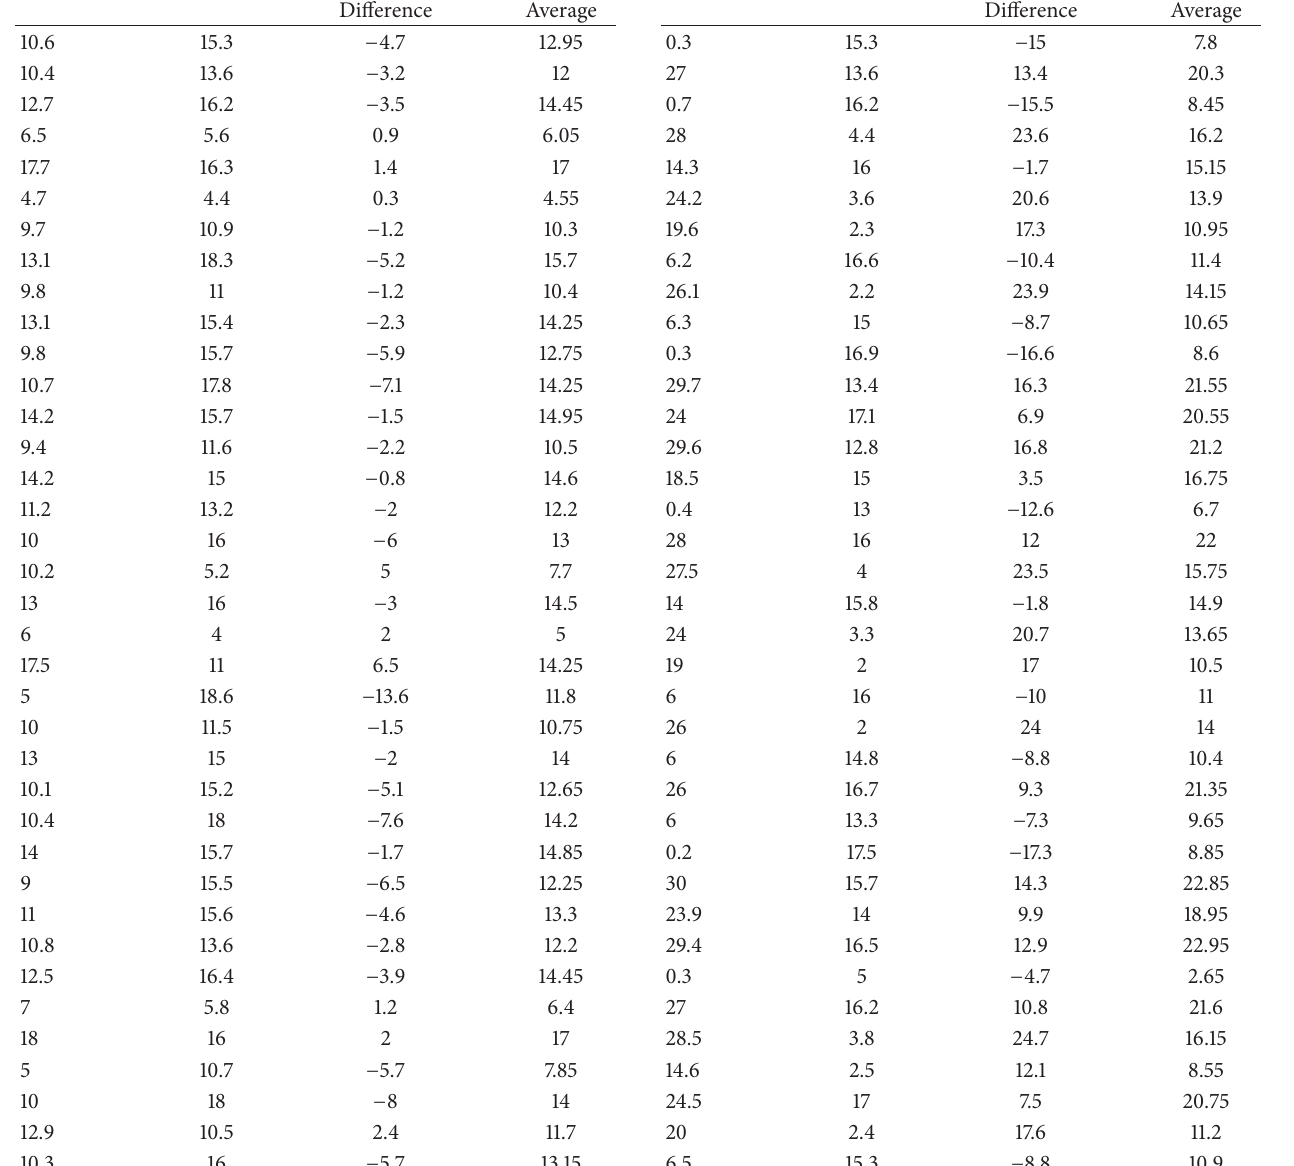
Table 5: Quarter I-N/S-T Bland-Altman analysis (see Figure 7). Method 1